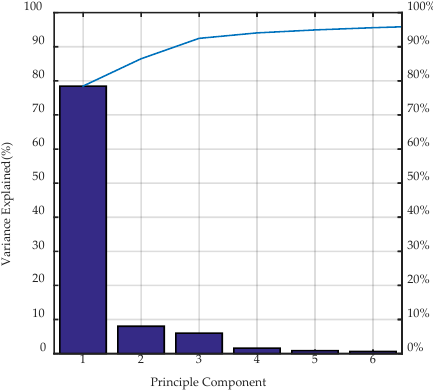
Figure 5. Result of PCA on a left ear’s HRTF logarithmic magnitudes .